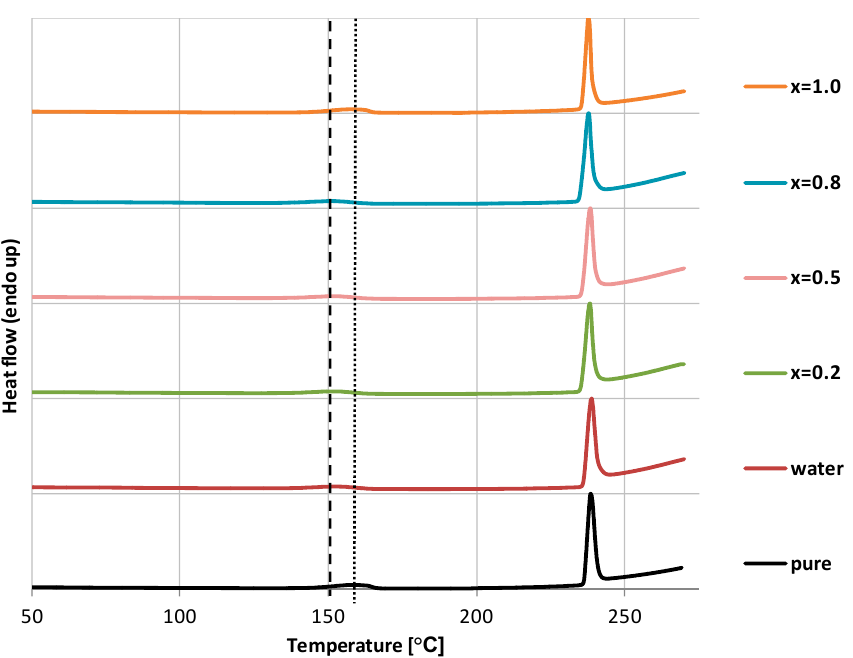
Figure 1. The FTIR spectra of caffeine precipitates after solubility measurements in NADES (cho- line chloride + glycerol), water and their mixtures. Values in parentheses indicate the mole fractions of ccNADES in solute-free solutions. For comparison, the spectrum of pure caffeine is presented.